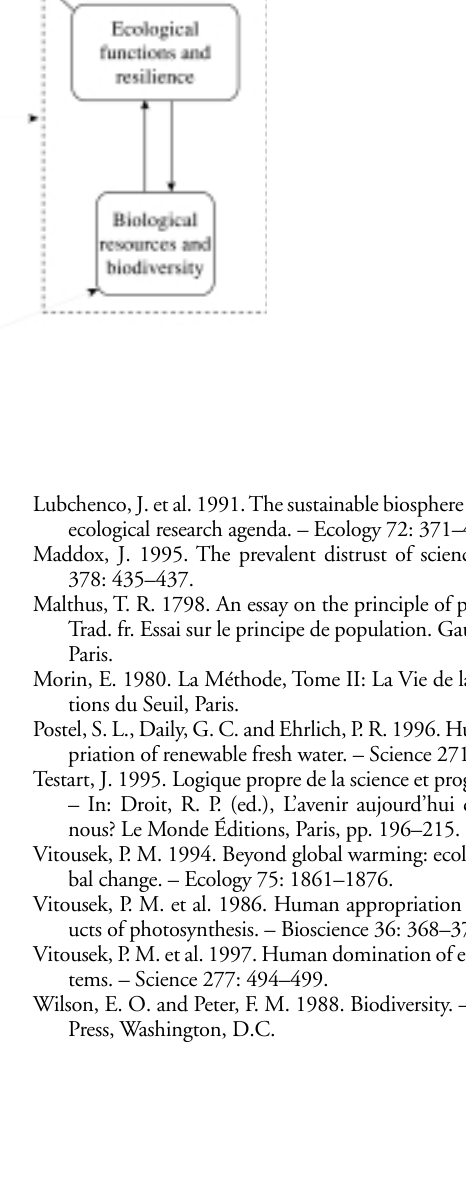
Fig. 4. Economic environ- mental linkages associated with biodiversity loss (from Barbier et al.